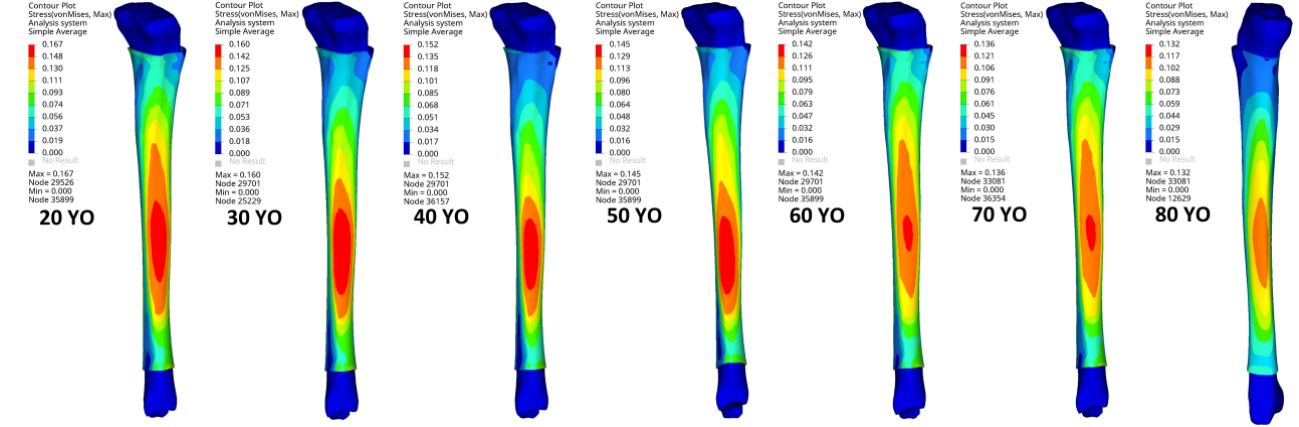
Figure 9. Comparison of the Von mises stress contours of the tibia in seven ages at 40 km/h.